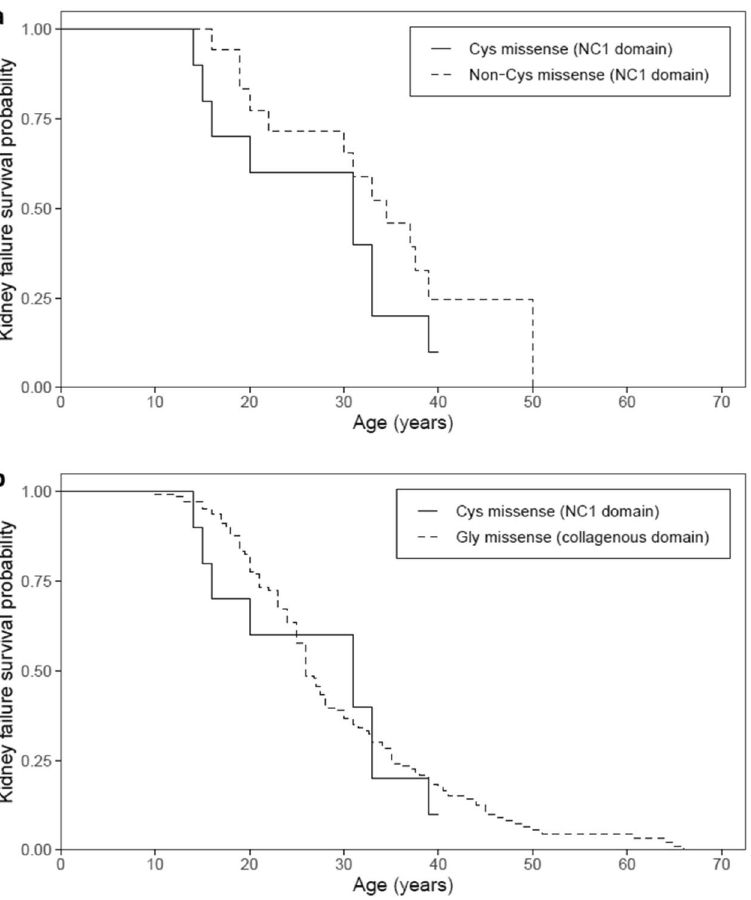
Figure 1. Proportion of cases without kidney failure for males with collagen IV α5 missense variants reported in LOVD. Cys missense variants in the NC1 domain were compared with (a) other missense variants in the NC1 domain ( p = 0.23) and (b) Gly missense variants in the Gly-X–Y collagenous domain ( p = 0.77). Censored data points are not